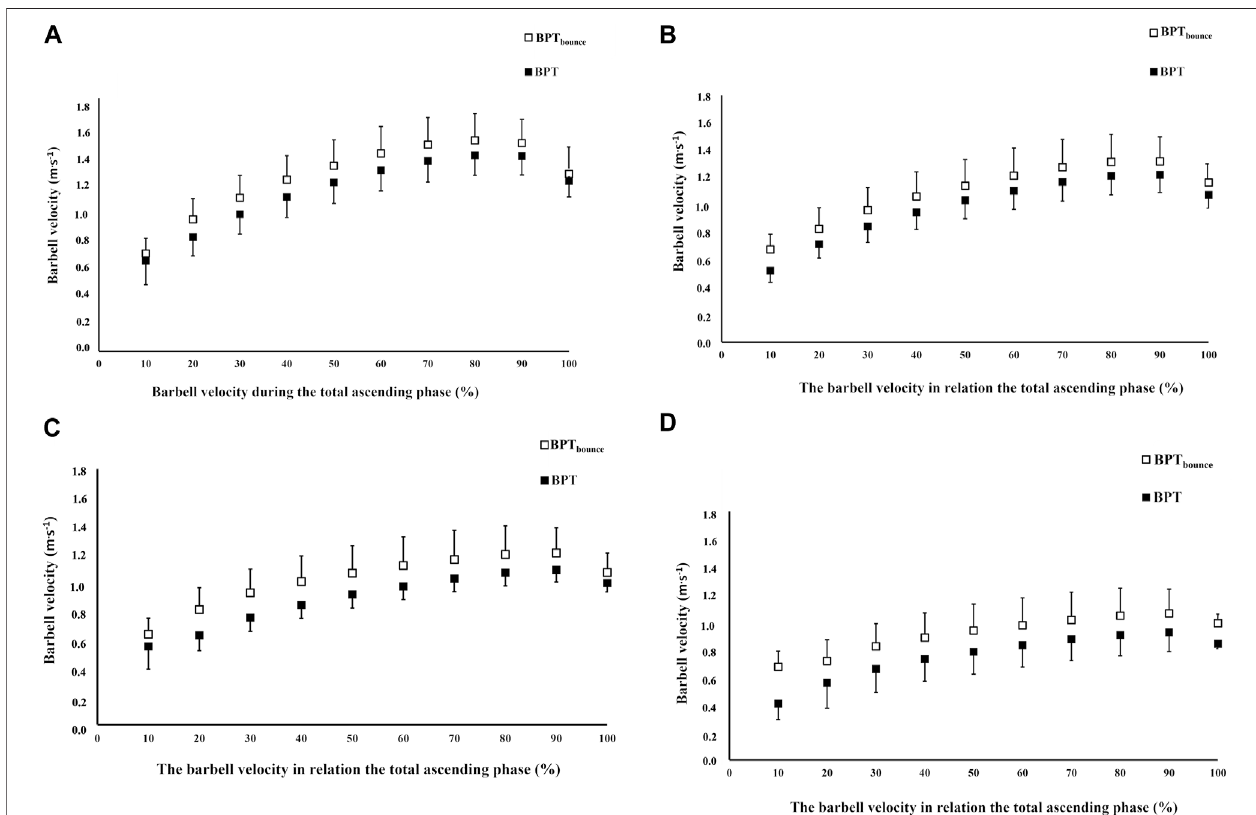
FIGURE1| BarbellvelocityrelativetothebarbellpositiontotheascendingphasefortheBPT bounce techniqueandBPTforeach30 kg (A) ,40 kg (B) ,50 kg (C) ,and 60 kg (D) .